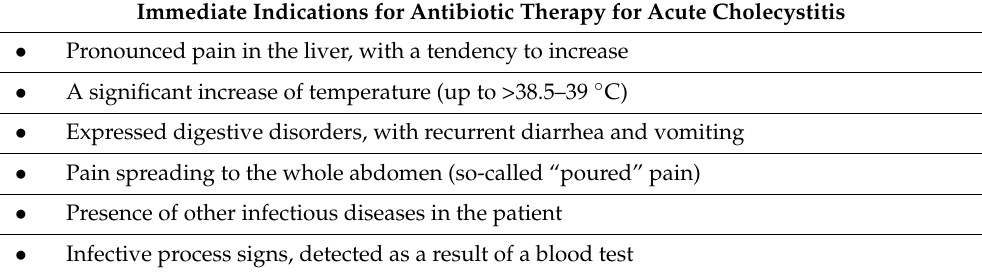
Table 2. In this table are summarized the clinical features and symptoms for which it is recommended to immediately begin antibiotic therapy for patients with acute